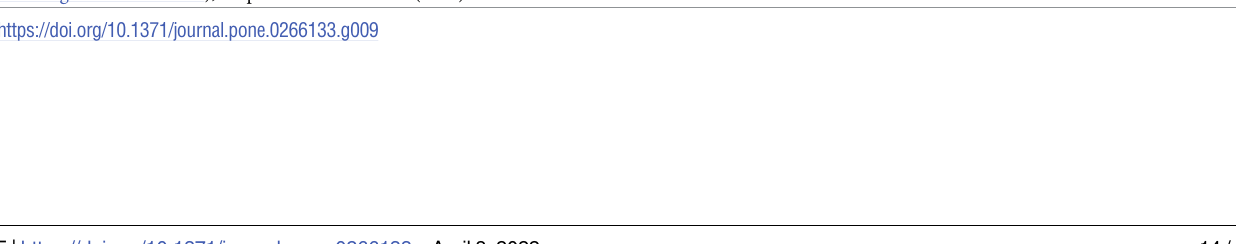
PLOS ONE | https://doi.org/10.1371/journal.pone.0266133 April 8, 2022 14 /